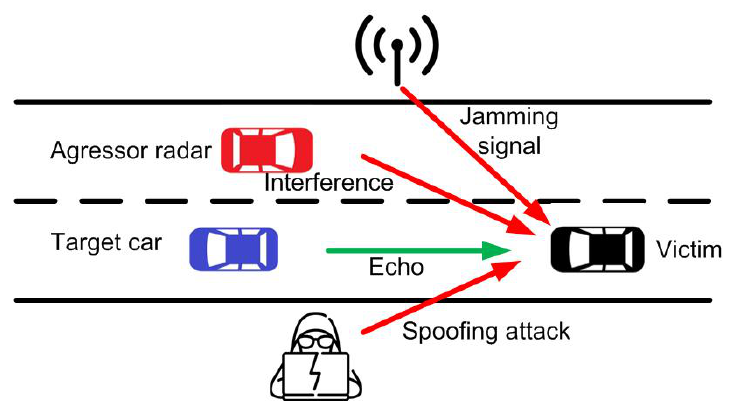
Figure 1. Illustration of a road scenario where the victim’s radar receives the echo signal from a target and is interfered with by another radar, a jamming transmitter, and an spoofing attack.